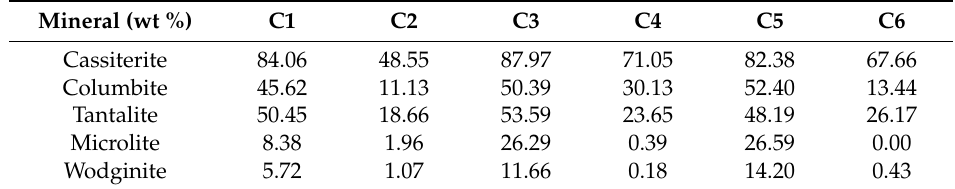
Figure 9. Mineral locking of CGM from the Penouta open pit. Table 3. Free surface of ore minerals from the Penouta open